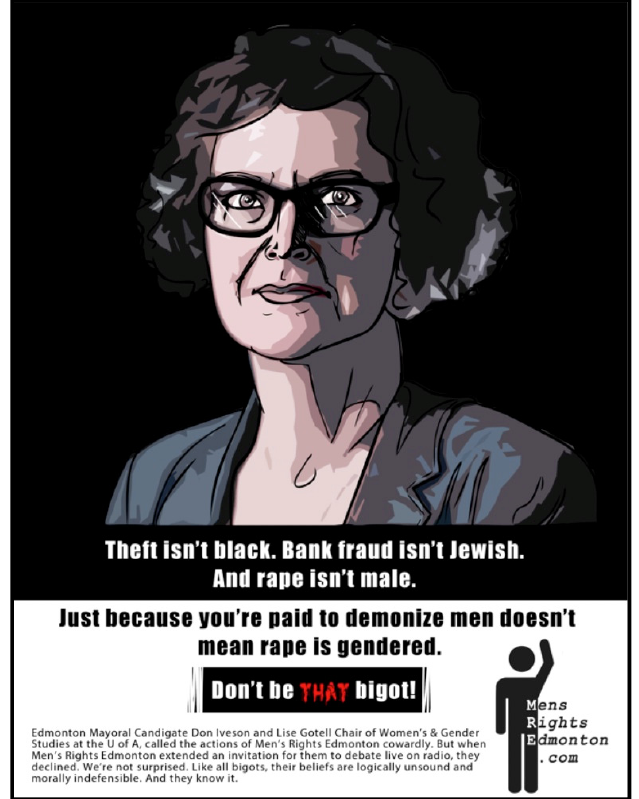
Figure 2: ‘Don’t be THAT Bigot’ poster (MRE 2013a) Emily